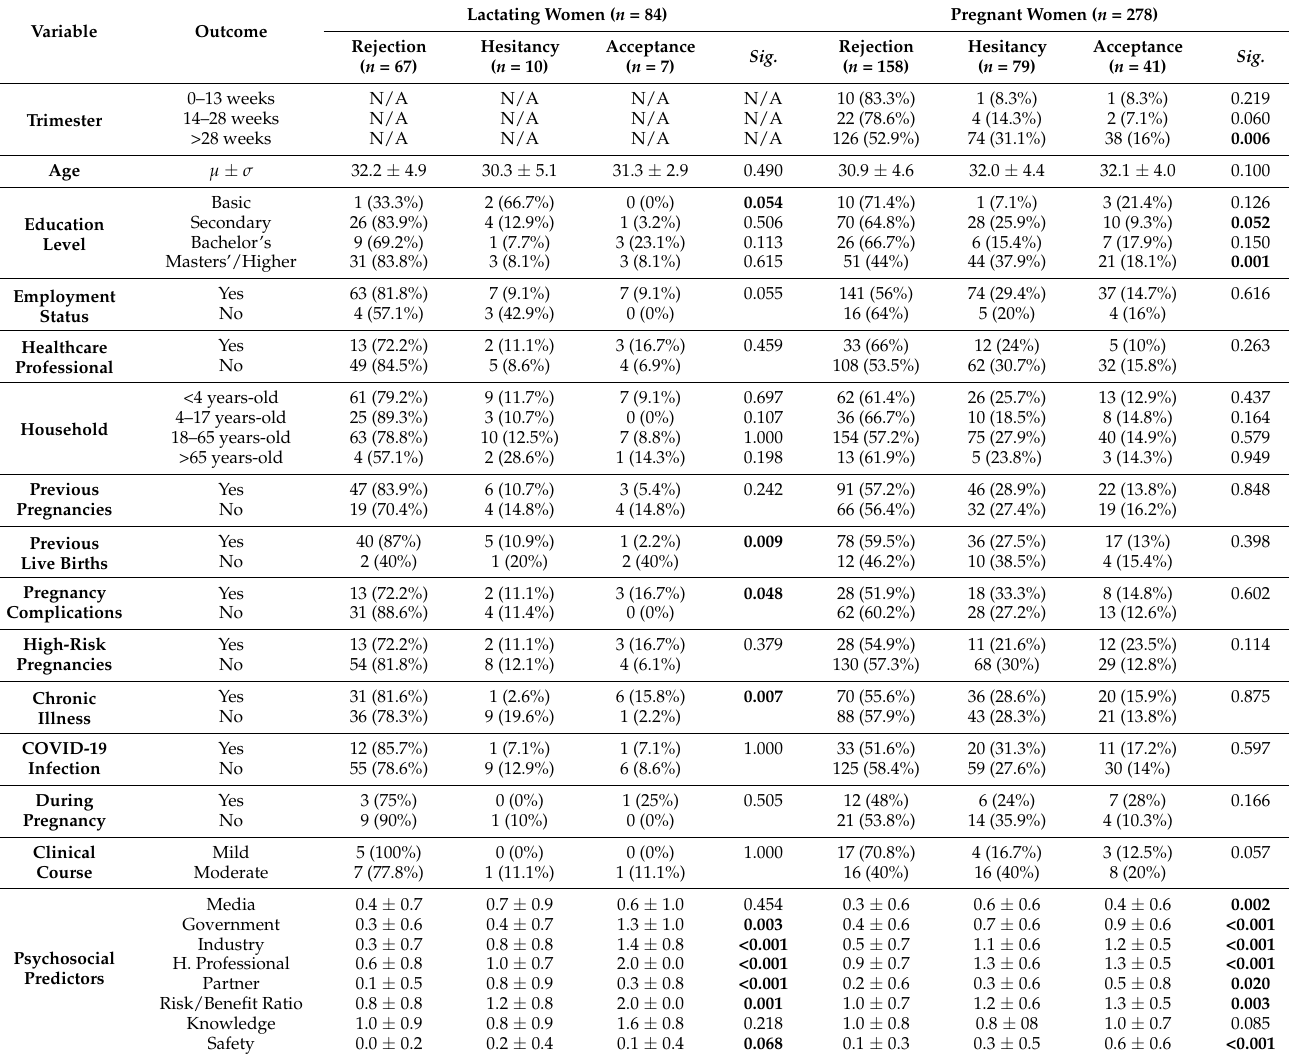
Table 8. Demographic, anamnestic and psychosocial determinants of pregnant and lactating women (PLW)’s responses to physicians’ recommendations, University Hospital Brno, August–October 2021 ( n =